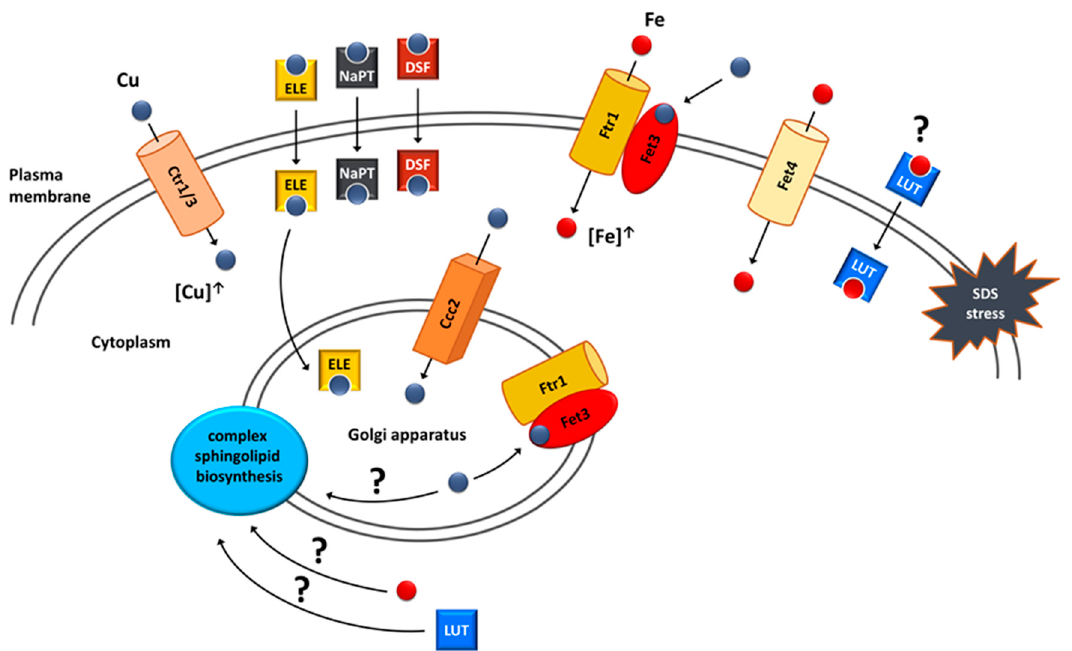
Figure 5. Suppression mechanisms of vps13 Δ SDS hypersensitivity that involve copper or iron homeostasis. Suppression could be achieved by (I) overexpression of genes encoding copper transporters Ctr1, Ctr3 and Ccc2; (II) overexpression of the FET4 gene encoding the Fet4 iron transporter; (III) treatment with copper ionophores (ELE—elesclomol; NaPT—sodium pyrithione; DSF—disulfiram); (IV) treatment with luteolin (LUT). Internalised copper is targeted to the Golgi apparatus where it